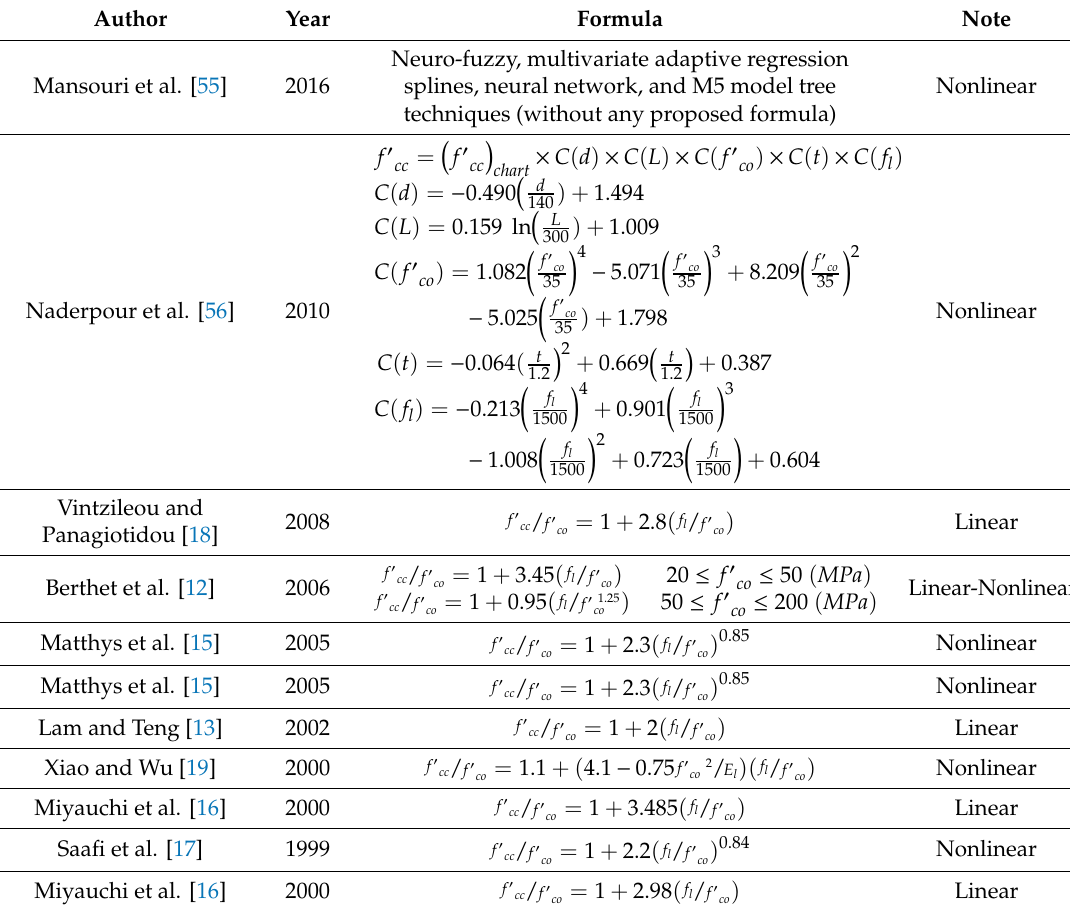
Table 1. Some of the existing formulas for predicting the compressive strength of fiber-reinforced polymer-confined concrete cylinders